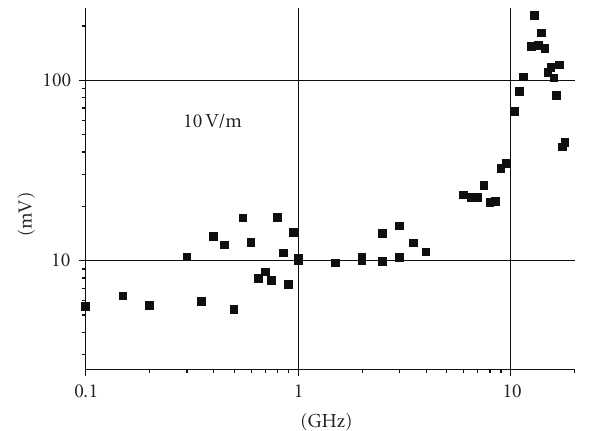
Figure 5: The diode DC output normalized to 10 V/m field